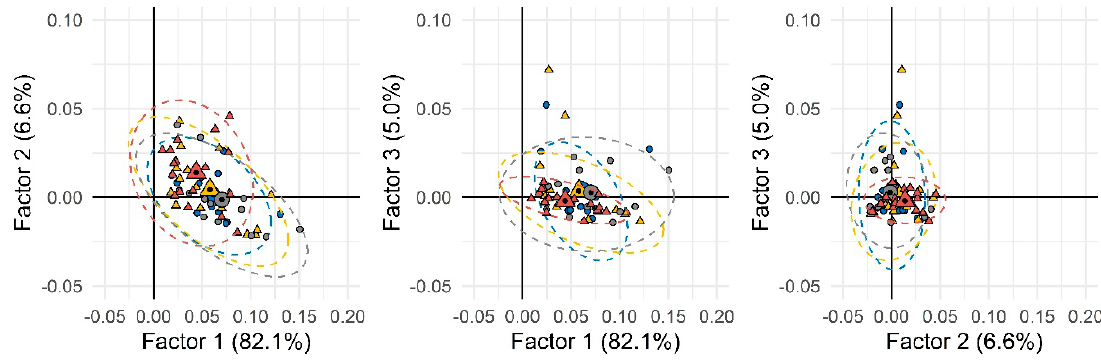
Figure 1. Principal component analysis (PCA) scores-plot based on all detected peak-region features over the entire sample set. Group 1 (less sedentary group) and Group 2 (more sedentary group) were depicted as circles and triangles, respectively. Different colors were used to indicate males (blue and yellow) and females (gray and dark red). Small and large (with a black spot) symbols represent individual and mean values, respectively.